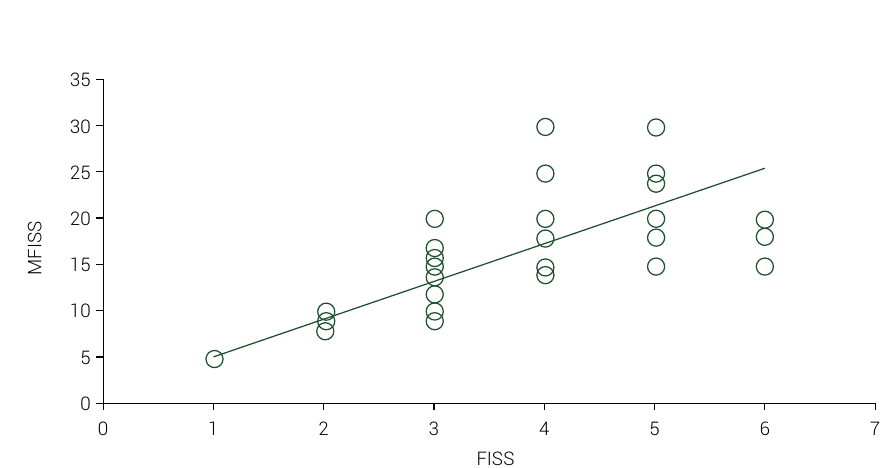
Figure 1. Correlation between FISS and MFISS scores registered among study sample.